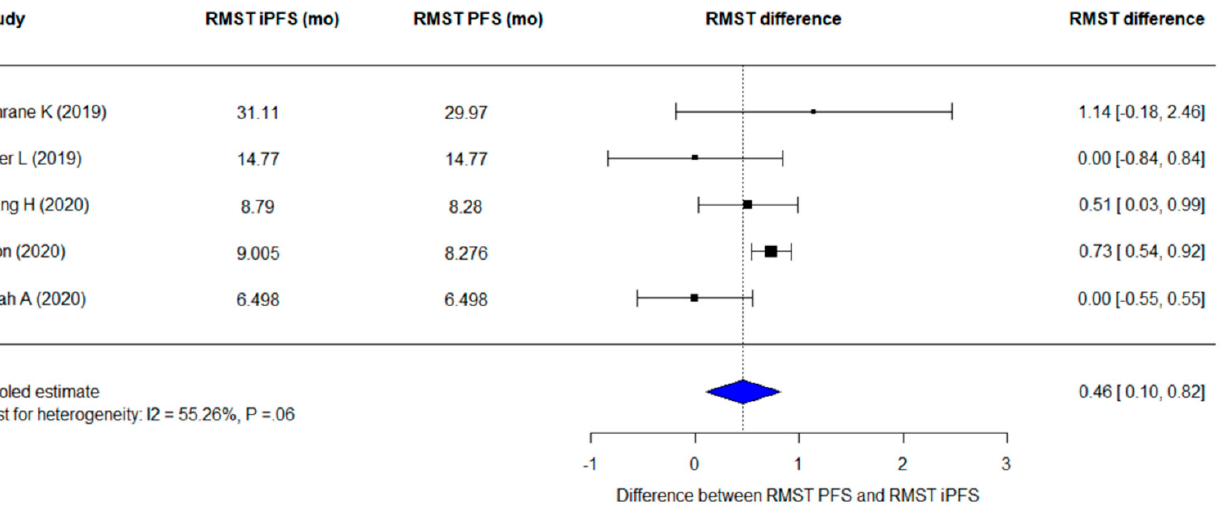
Figure 4. A forest plot for the difference of RMST of PFS per RECIST 1.1 and iPFS per iRECIST. The pooled difference of RMST of PFS per the two criteria are 0.46 (95% CI, 0.10–0.82 months; p = 0.01). iRECIST-based estimates are indicated as “i”. Abbreviations: PFS, progression-free survival; RMST, restricted mean survival time.